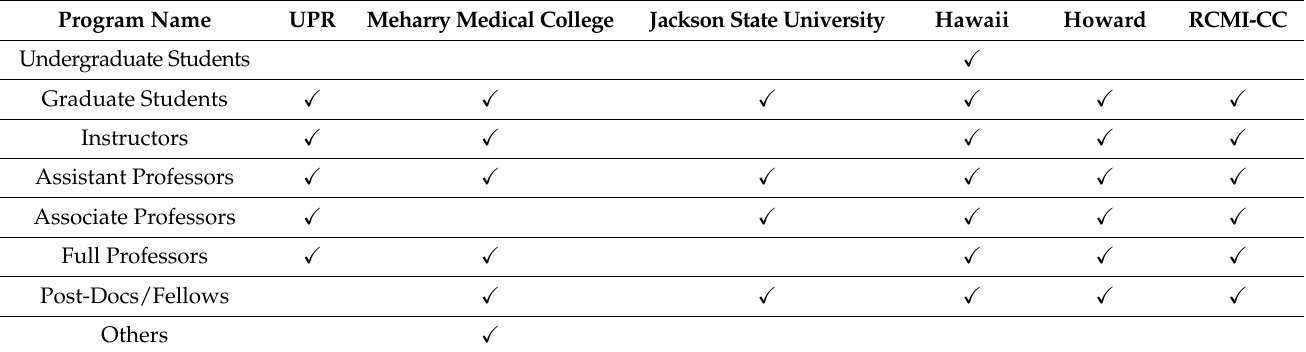
Table 1. Demographic Targets of all participating programs.